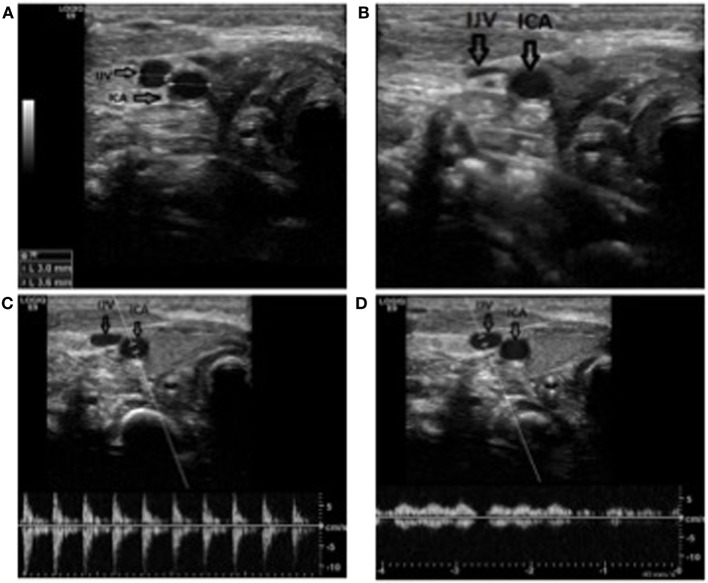
Anatomical identification of the internal jugular vein. (A) The vessel in short axis view in a newborn at term. Notice the diameters. IJV: internal jugular vein; ICA: internal carotic artery. (B) Notice how the vein collapses under a slight pressure, as oppose to the artery. (C) Doppler demonstrating the pulsatile flow in the artery. (D) Doppler demonstrating the laminar flow in the vein. Notice how the flow changes with the respiration.